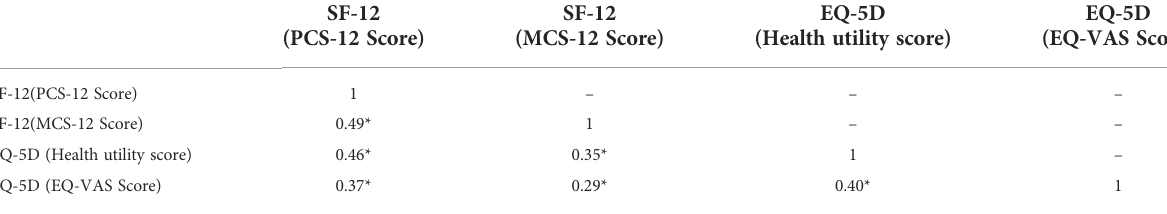
TABLE 3 MTMM matrix analysis Correlation between EQ-5D-3L and SF-12